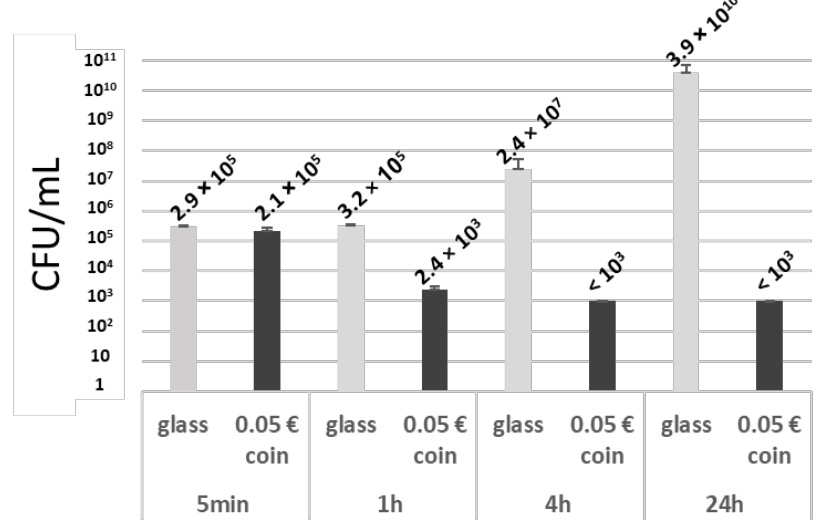
Figure 2. Level of surviving bacteria (CFU/mL) after contact during various time periods (5 min, 1 h, 4 h and 24 h) with the negative control glass surface (light grey) or the 5 cent Euro coin (dark grey) positive control.